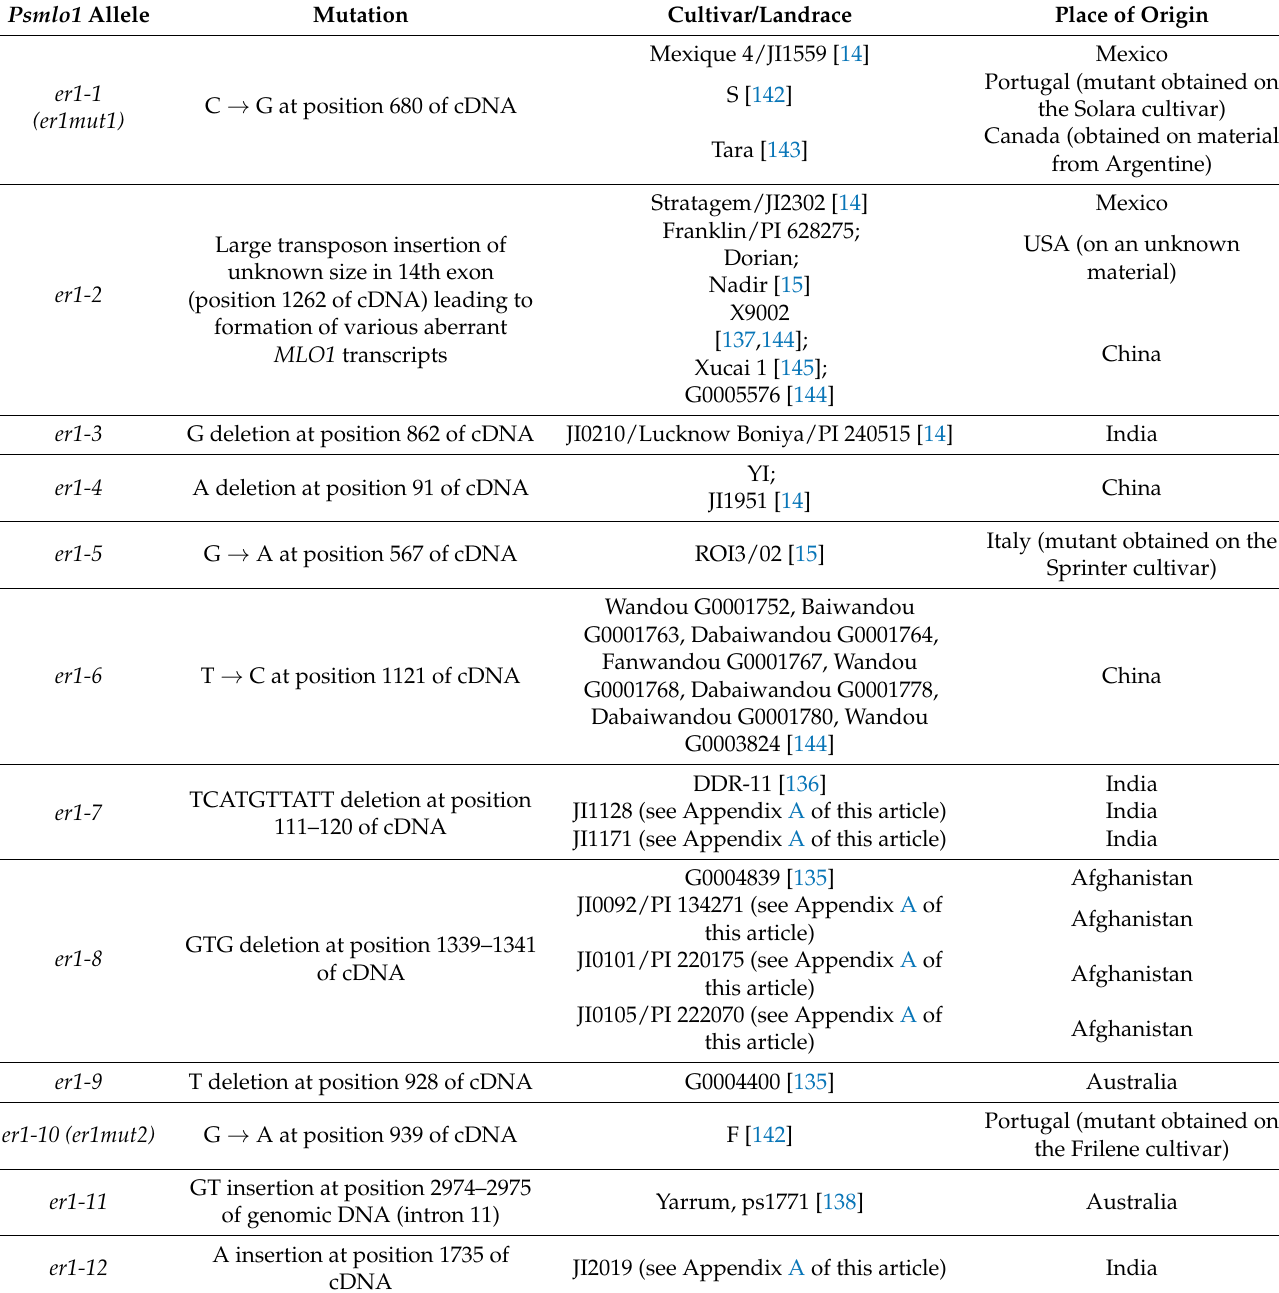
Table 1. List of known Psmlo1 ( er1 ) alleles conferring resistance to powdery